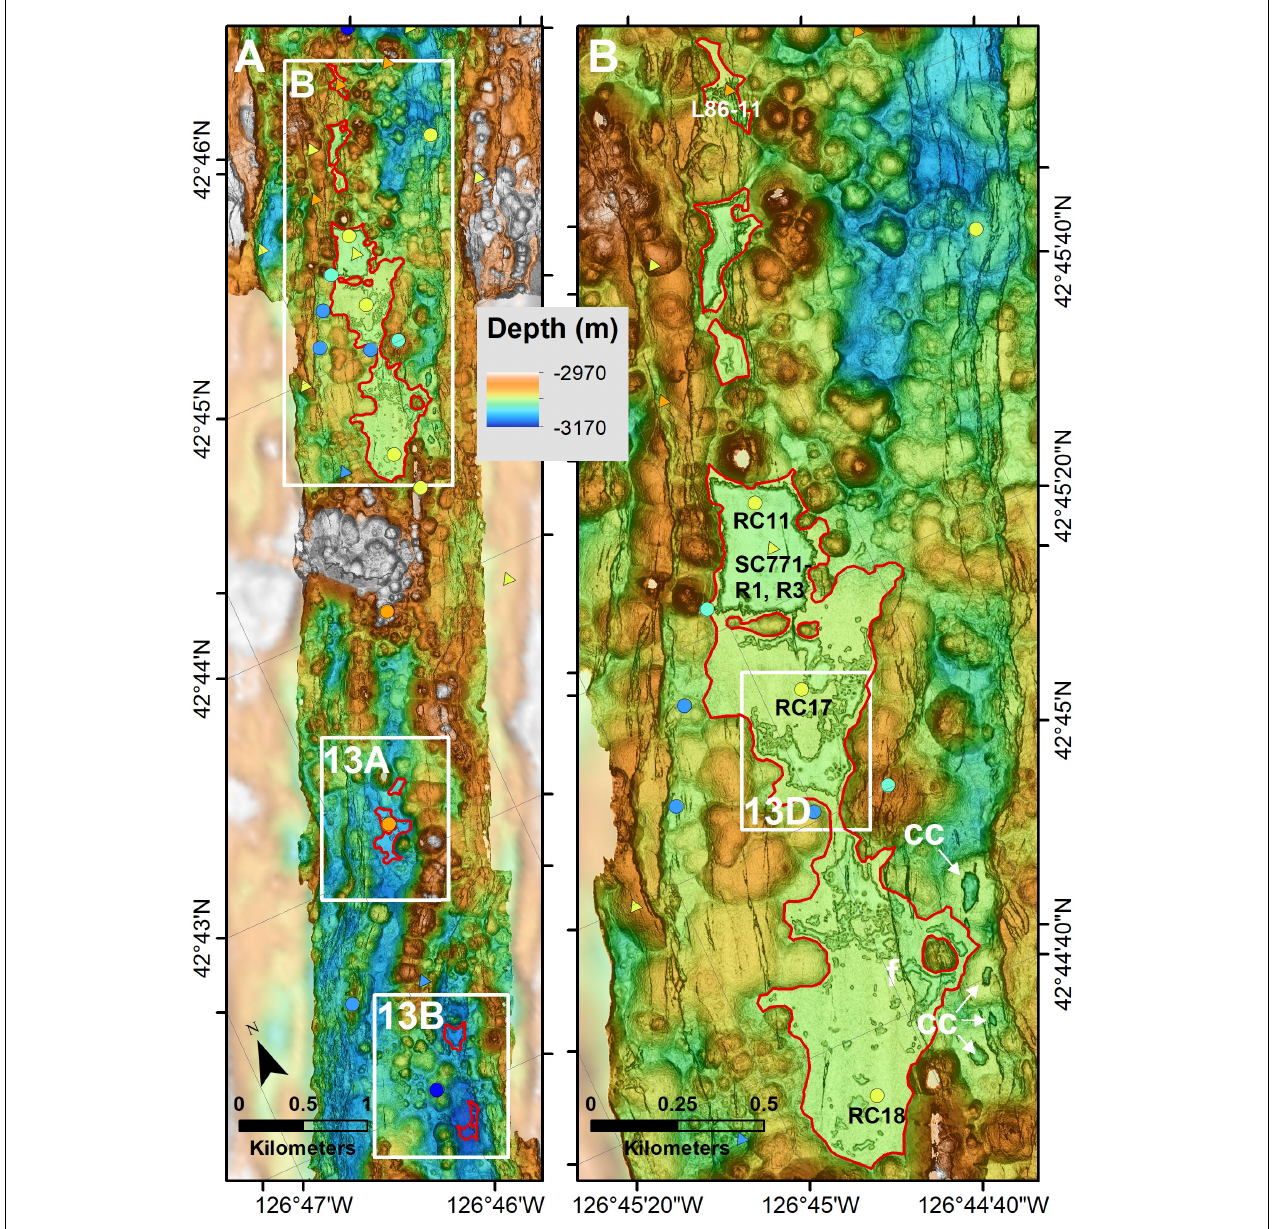
FIGURE 12 | (A) Map showing the distribution of ponded channelized flows. At least three eruptions produced ponded channelized flows in the axis (outlined by red lines), each with two or more separate flows. The locations of Figures 12B , 13A,B are shown as white boxes. (B) The four northern flows were sampled twice during Sea Cliff dive 771 (Rona et al., 1990) and by three rock cores (Davis et al., 2008). The flows are younger than the older surrounding hummocky flows they ponded against, but are cut by a fault (f) and have thin sediment cover as observed during the Sea Cliff dive (Rona et al., 1990) and in several camera tows (Clague and Rona, 1990). Four inflated hummocky flows with summit craters (cc) are labeled. The location of Figure 13D is shown by the white box. Maps A and B are rotated counterclockwise 23 ◦